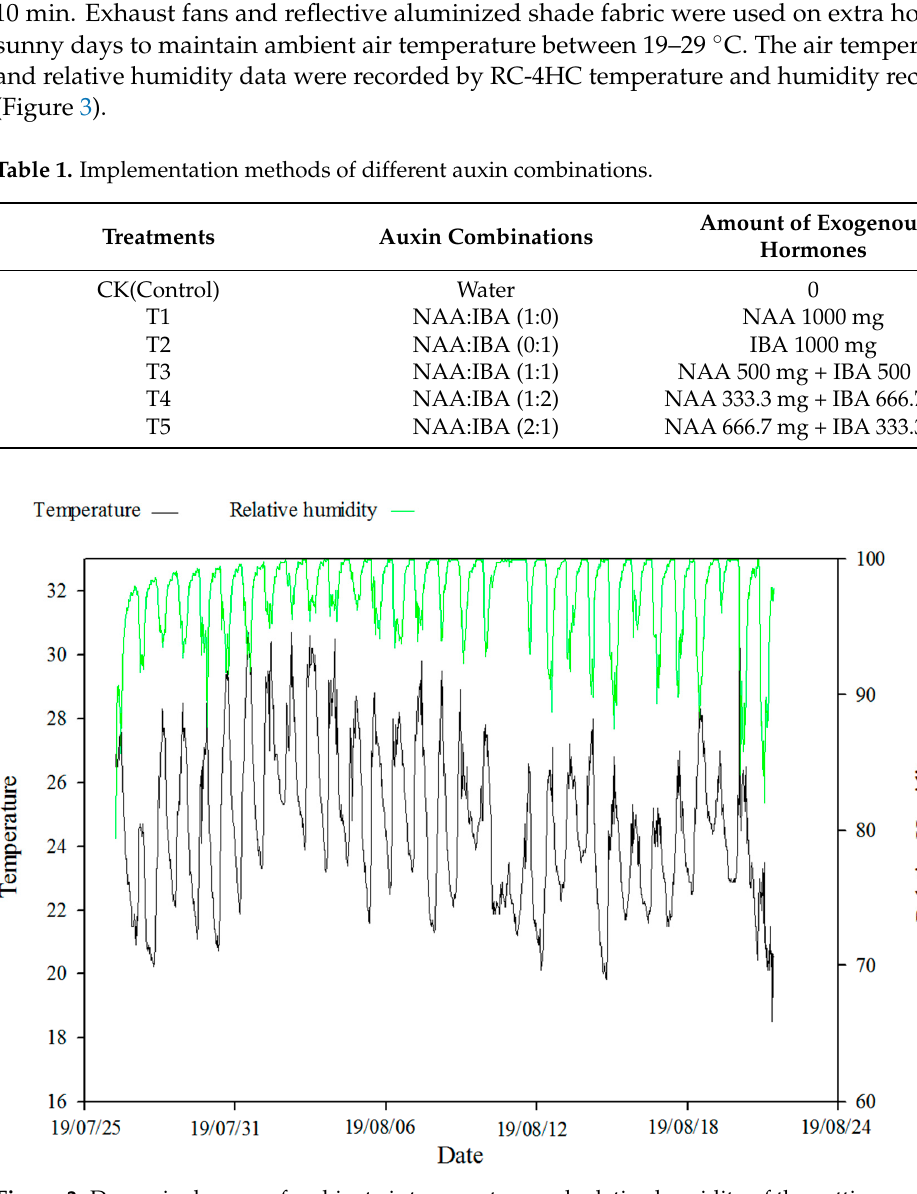
Figure 2. Cutting seedbeds and seedlings.